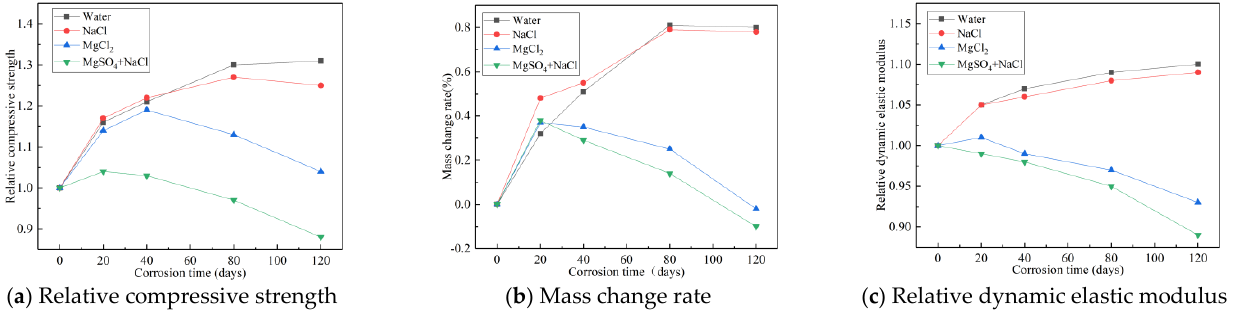
Figure 7. Influences of Cl − on Physical Properties of MK Concrete.